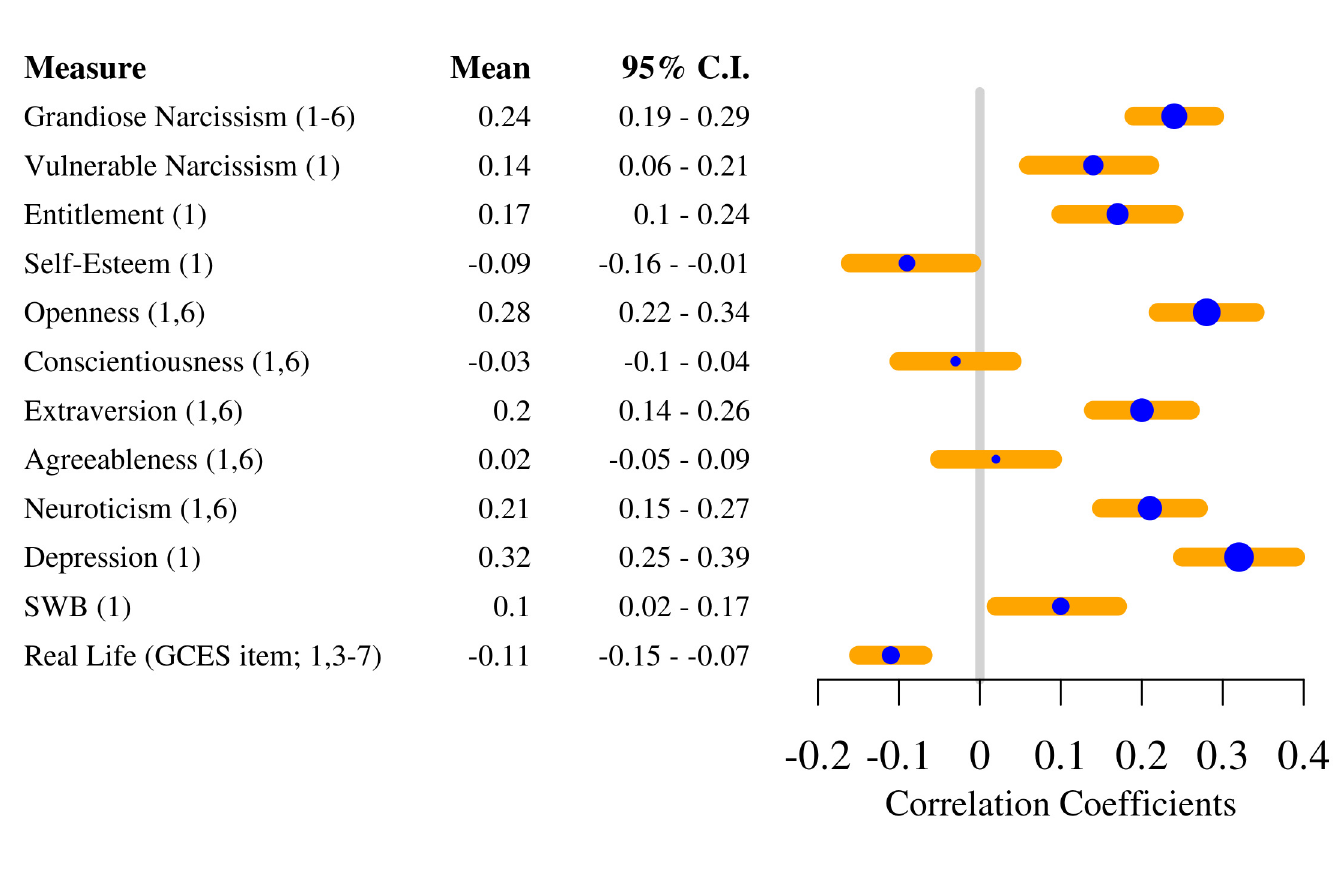
Fig 1. Forest plot of average correlations across studies for selected individual differences